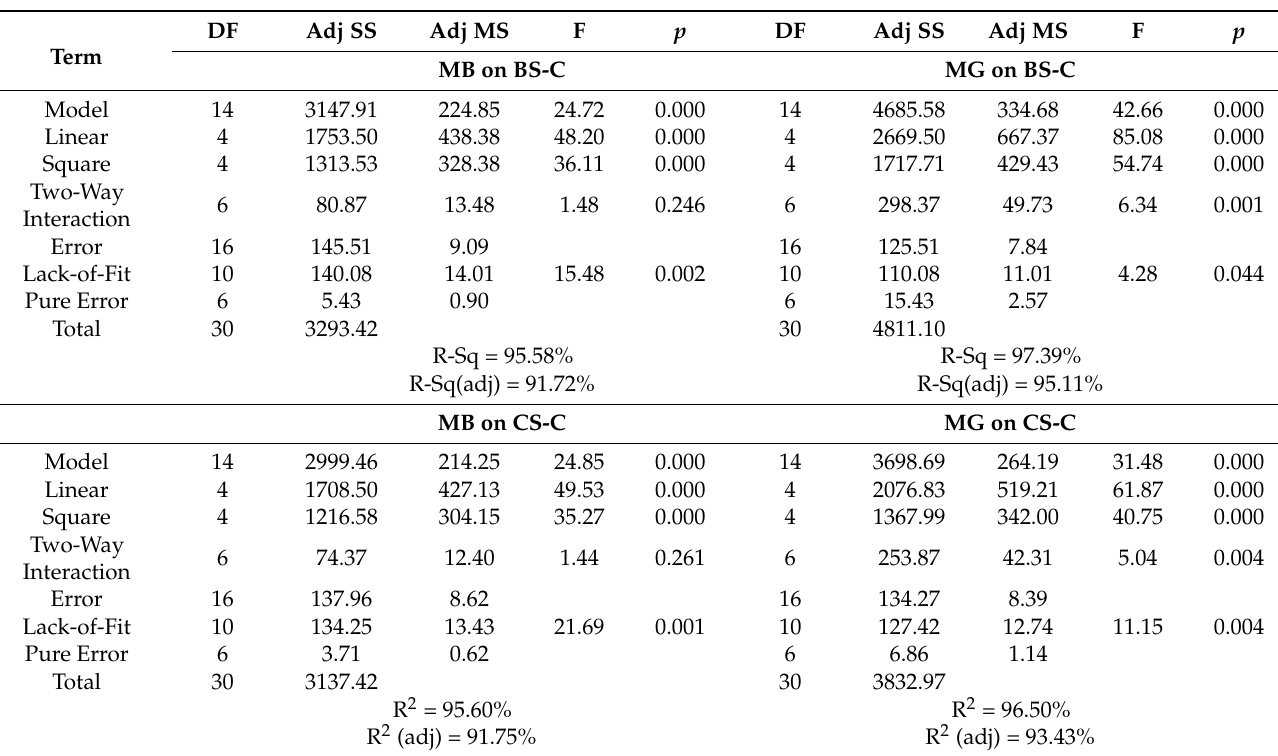
Table 6. ANOVA of cationic dye removal